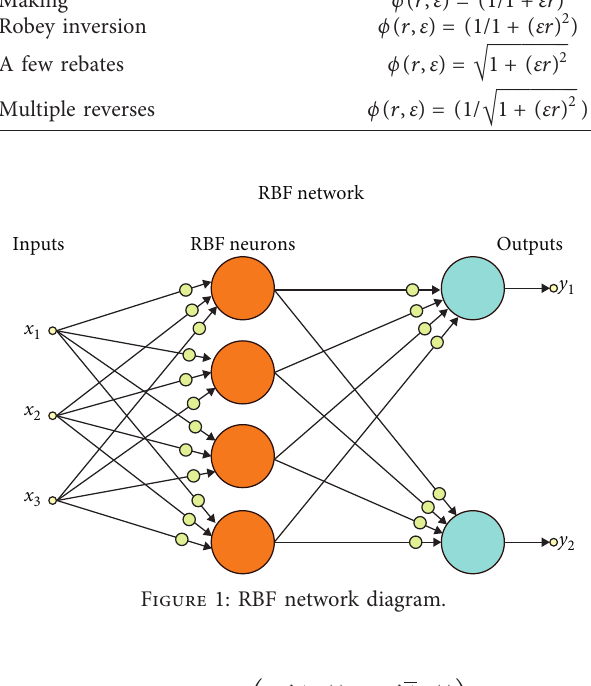
Figure 1: RBF network